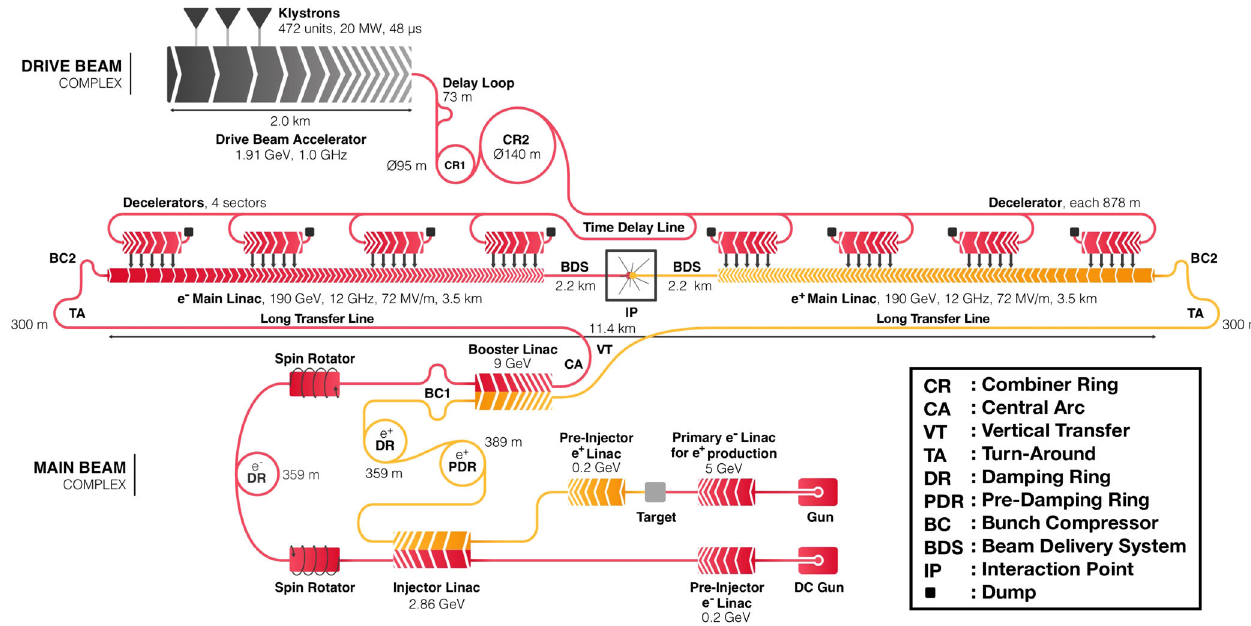
(0,0,-100).FIG. 1. Schematic diagram of CLIC at 380